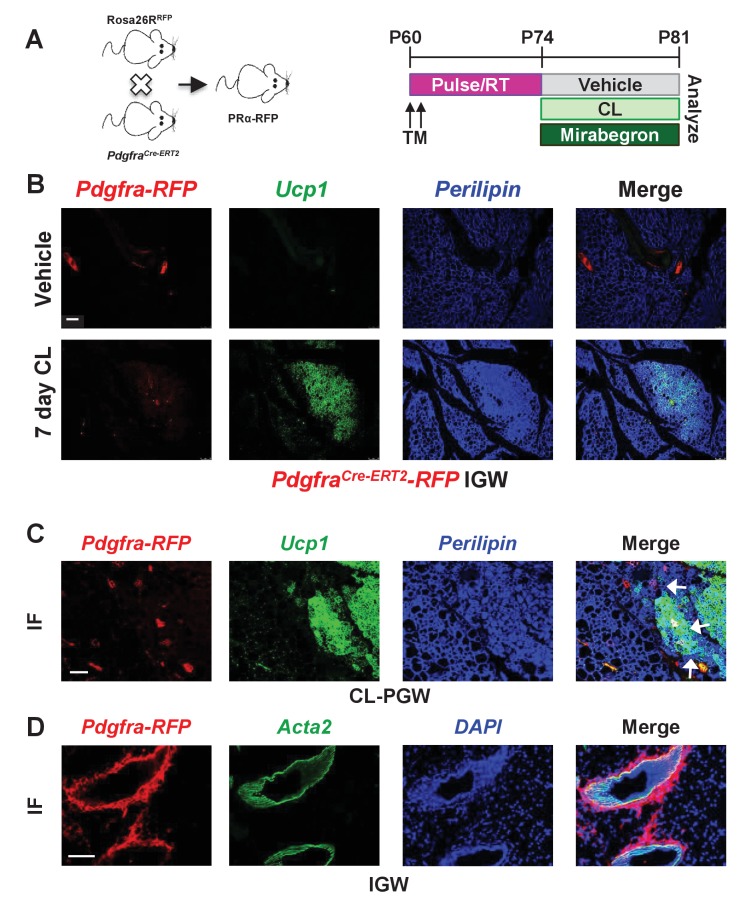
PDGFRa+ cells are not a major source of Adrb3 induced beiging.(A) Illustration of mice and experimental regime: two-month-old PdgfraCre-ERT2; RosaR26RFP male mice were administered one dose of TM for two consecutive days. Two weeks post TM, mice were randomized to vehicle, CL or mirabegron for seven days (n= 6/group). (B) Representative lower magnification images of IGW adipose sections from mice described in (A) treated with vehicle or CL. Scale bar = 100 µm. (C) Representative images of fate mapping analysis of PdgfraCre-ERT2-RFP+ cells into Ucp1 [Ucp1 (green) and Perilipin (blue)] beige adipocytes within PGW depots from mice described in (A) treated with CL. (D) Representative images immunostaining of Pdgfra-RFP (red), Acta2 (green) and DAPI (blue) from IGW depot section from TM-pulsed PdgfraCre-ERT2; RosaR26RFP male mice. Scale bar = 100 µm.